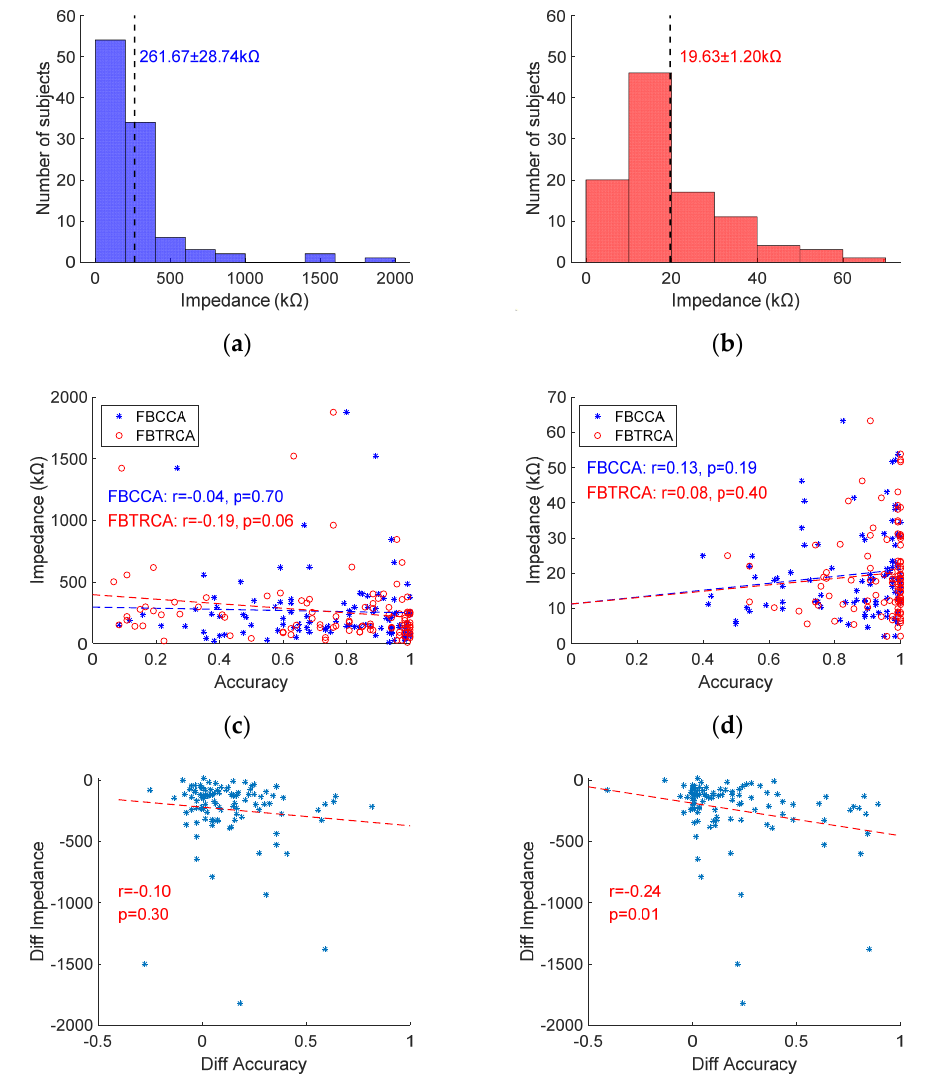
Figure 9. Impedance distribution of ( a ) dry and ( b ) wet electrodes across all subjects. Correlation analysis of the classification accuracy and impedance for ( c ) dry and ( d ) wet electrodes, as well as the accuracy difference and impedance difference between wet and dry electrodes: ( e ) FBCCA, ( f ) FBTRCA. The dotted lines represent the results of linear regression.